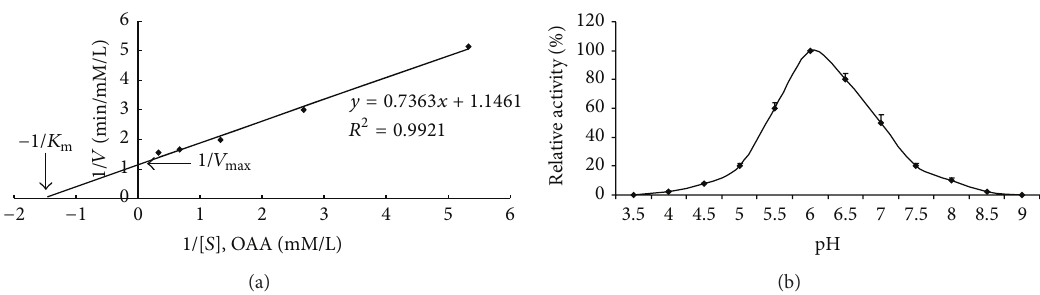
Figure 4: The influence factors of enzymatic activity. (a) The conversion-rate (V) of OAA ( S ) to L-malate was measured at 340 nm using reaction of 1 𝜇 g of His-MDH with nd pH and d racterizationvarious concentrations of OAA (0.1875–3 mM) at pH 6.0, 40 ∘ C. Measurements were performed at 1min intervals for 5min. Data from 3 independent assays were plotted by the method of Michaelis-Menten and fitted to ) . 𝐾 and 𝑉 max for His-MDH were determined to be 6.45 × 10 −3 M and 0.87 mM L −1 min −1 , respectively, by the equation 𝑉 = 𝑉 max ⋅ 𝑆/(𝑆 + 𝐾 m m means of a Lineweaver-Burk plot (double-reciprocal plot). Data shown here were the mean values ± standard deviations. (b) The maximal MDH activity occurred at pH 6.0. The experiments were performed in triplicate, and the bars represent standard deviations.